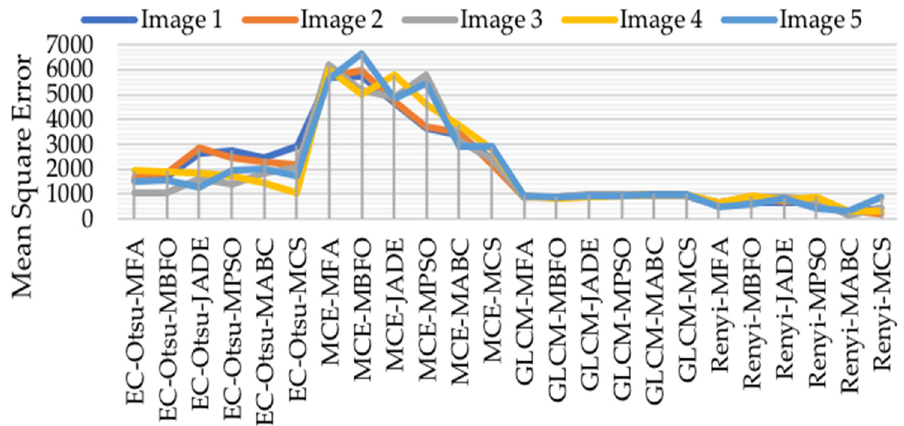
Figure 19. Results of MSE values for all algorithms at level 8.